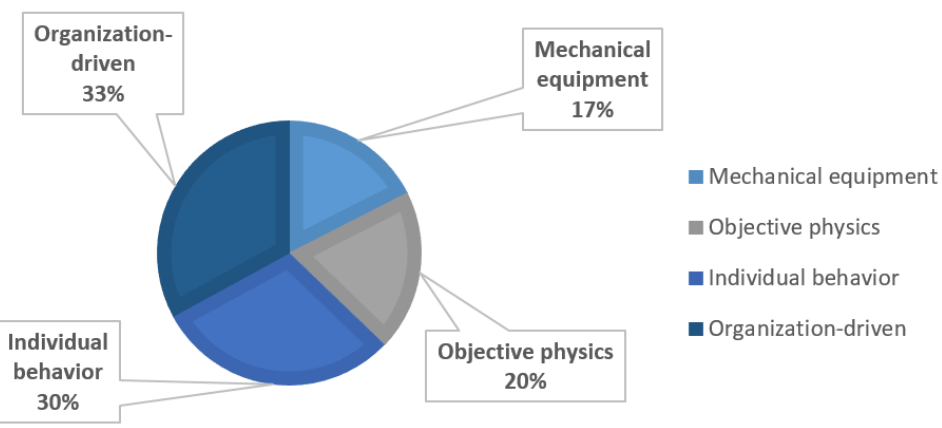
Figure 7. Types of precursors in the high-altitude falling accidents.